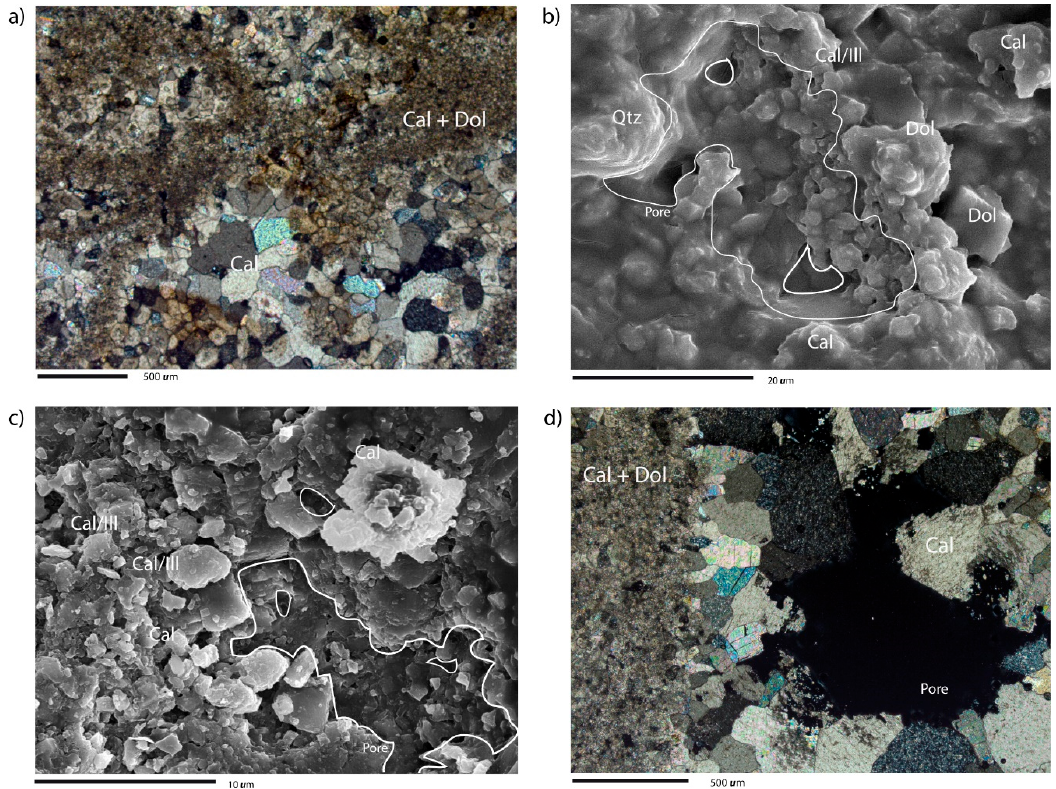
Figure 3. Characteristic textural features of the vuggy carbonates observed by OpM ( a , d ) and SEM ( b , c ). Table 1. Chemical composition of whole rock (vuggy carbonates) before (1: initial conditions) and after the experiment (2: dry CO 2 conditions and 3: wet CO 2 conditions). Uncertainty given by IGME Laboratory (SiO 2 8.20%; Al 2 O 3 11.57%; Fe 2 O 3 9.55%; MnO 9.31%; MgO 7.96%; CaO 6.80%; Na 2 O